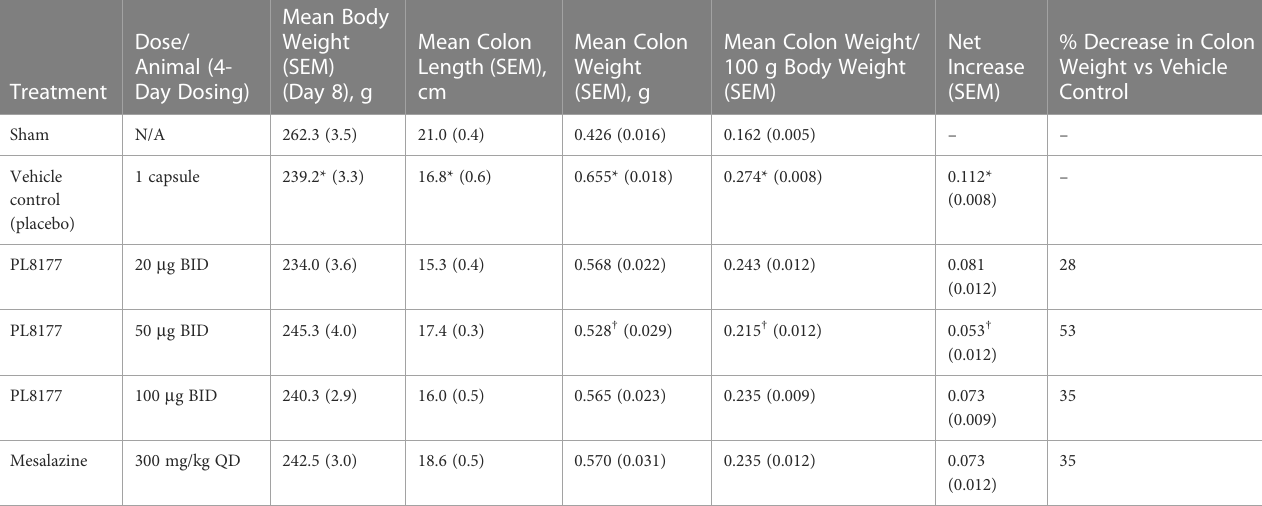
TABLE 2 Percentage difference from vehicle for colon weight and length on day 8 across studies and PL8177 doses in DSS colitis – induced rats.